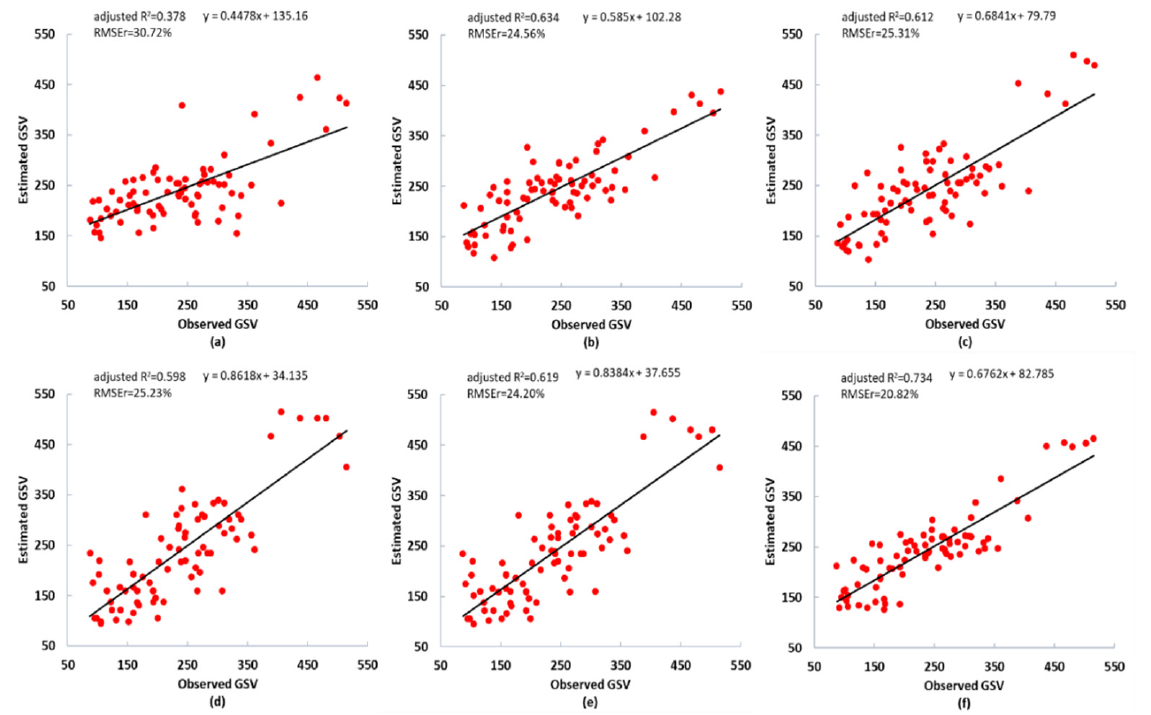
Figure 6. Scatter plots of the observed and estimated GSV values (m 3 /ha) using the combined GF-2 and Sentinel-2 image dataset with various feature variables selected by five methods based on the RFR or KNN models. ( a – d ) RF, SRF, KNN-FIFS, and DC_FSCK feature variable selection methods. ( e – f ) AFCO feature selection methods based on KNN and RFR models, respectively. The black line is the fitting trend of the estimated results.